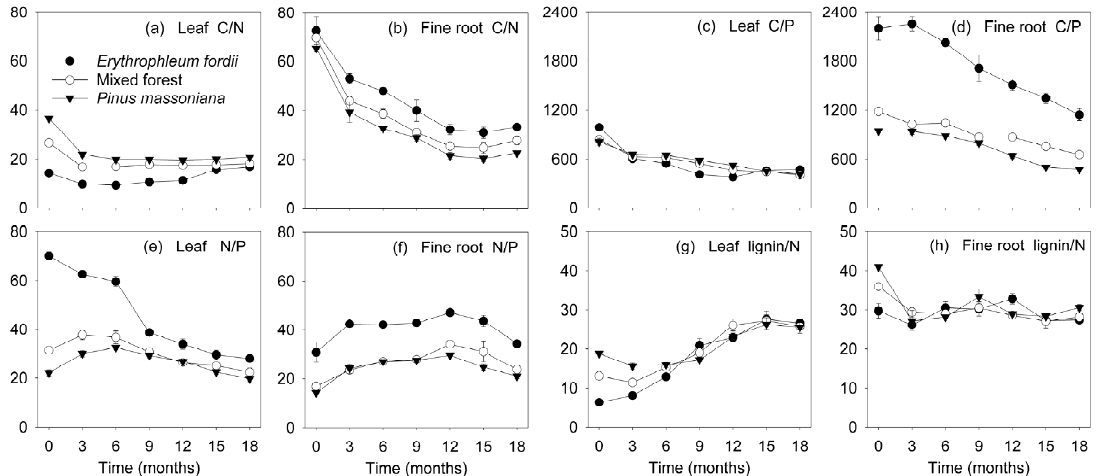
Figure 5. Dynamics of C/N, C/P, N/P, and lignin/N ratios (mean ± standard error, n = 3) in leaf and fine root litter of three subtropical plantations in China.